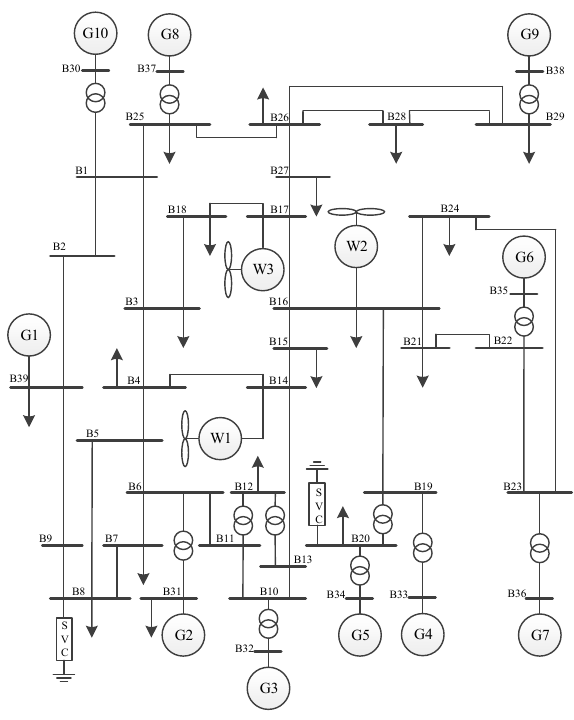
Figure 14. Modified IEEE 39 bus New England test system.